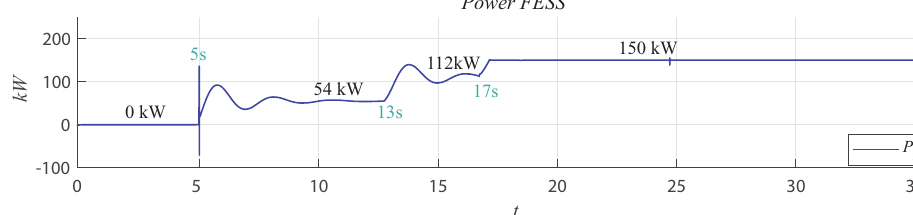
Figure 23. Power absorbed by the FESS for case study 3.